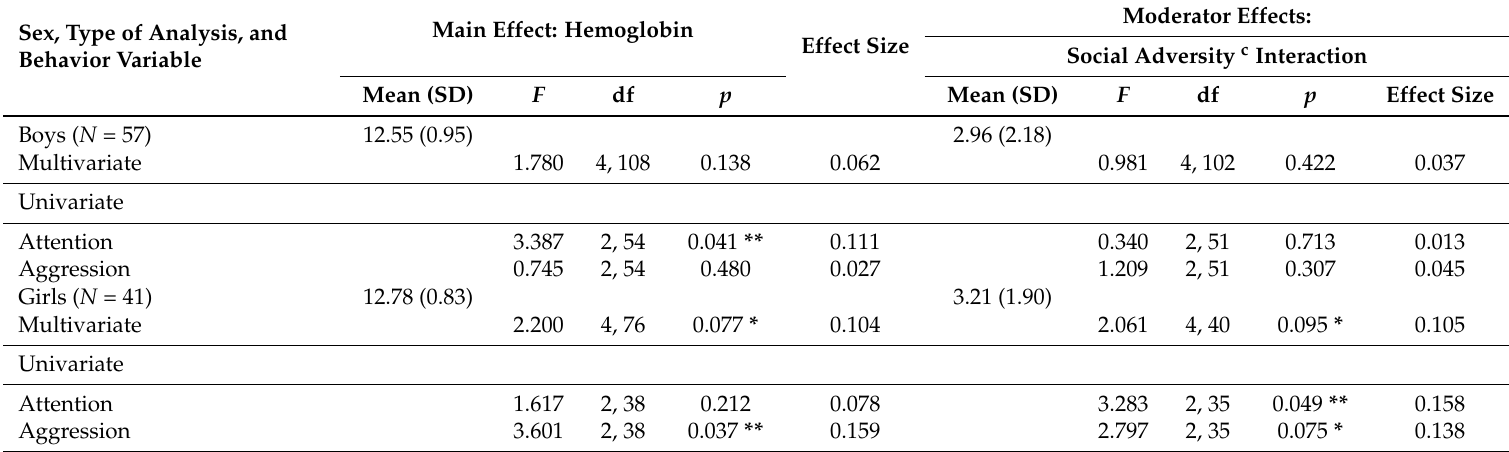
Table 4. Sex-stratified univariate and multivariate analysis of variance a of the effect of hemoglobin levels b at age 4 on externalizing behavior at age 6. Sex, Type of Analysis,